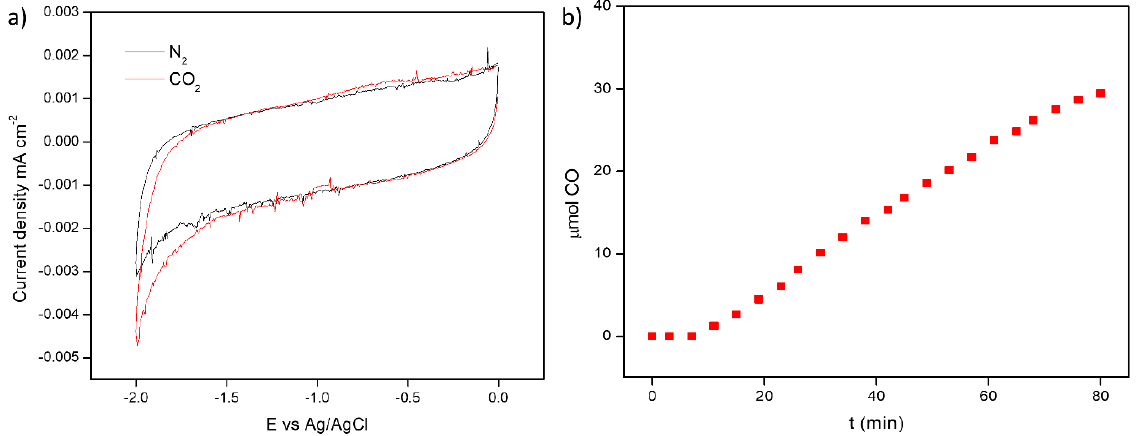
Figure 8. ( a ) Cyclic voltammetry tests on the electrode in N 2 -purged and CO 2 -saturated 0.1 M TBAPF 6 acetonitrile solutions; ( b ) CO quantification during a chronoamperometric test in an H-cell at −1.8 V vs. Ag/AgCl in CO 2 -saturated 0.1 M TBAPF 6 acetonitrile solution.